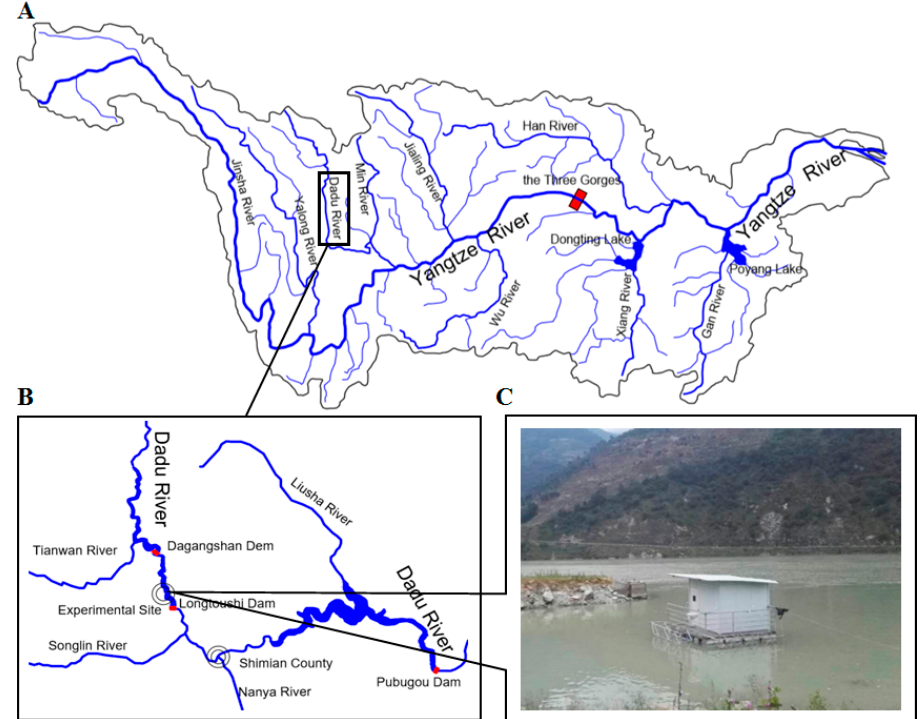
Figure 1. The experimental site during July and September 2017, which is located on the right bank of the Longtoushi Reservoir in the middle Dadu River, a tributary of the upper Yangtze River ( A , B ). ( C ) is a photograph of the study site and was taken by author Yuanming Wang.